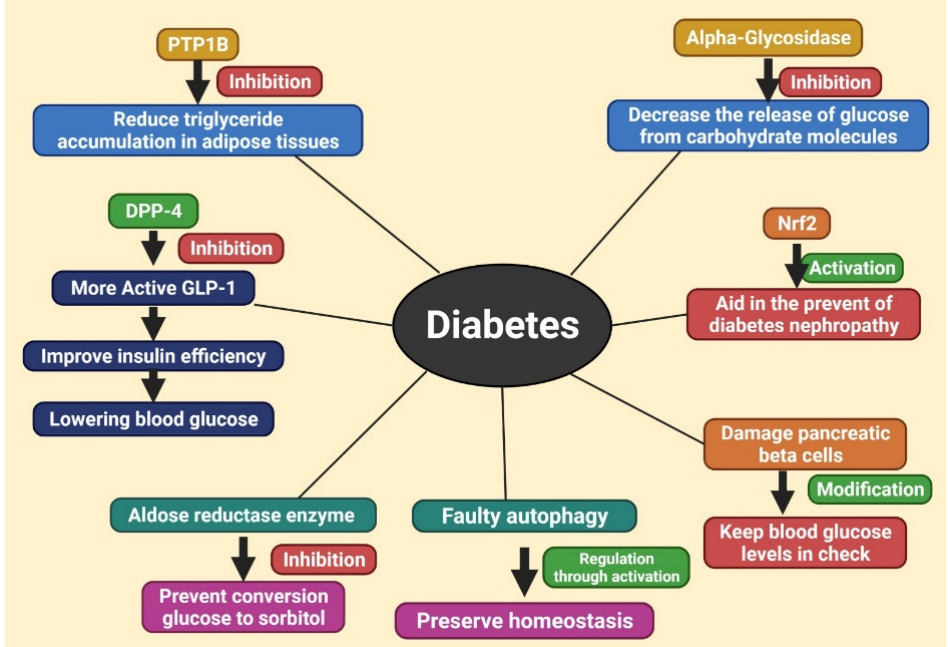
Figure 4. Different ways of treating